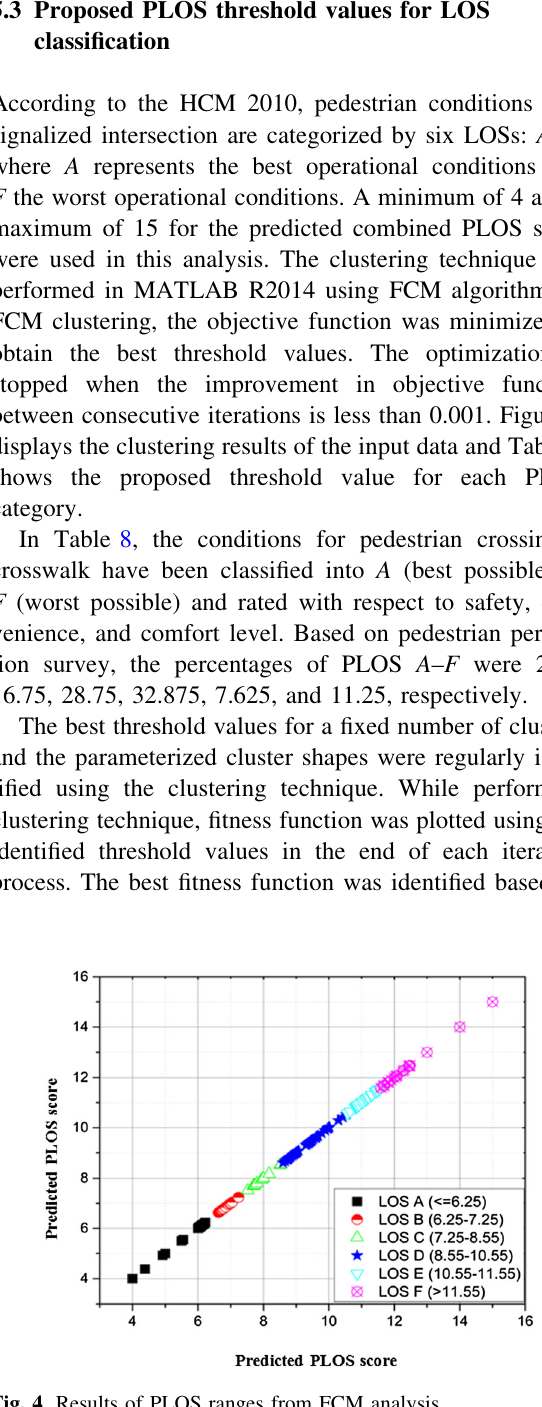
Fig. 4 Results of PLOS ranges from FCM